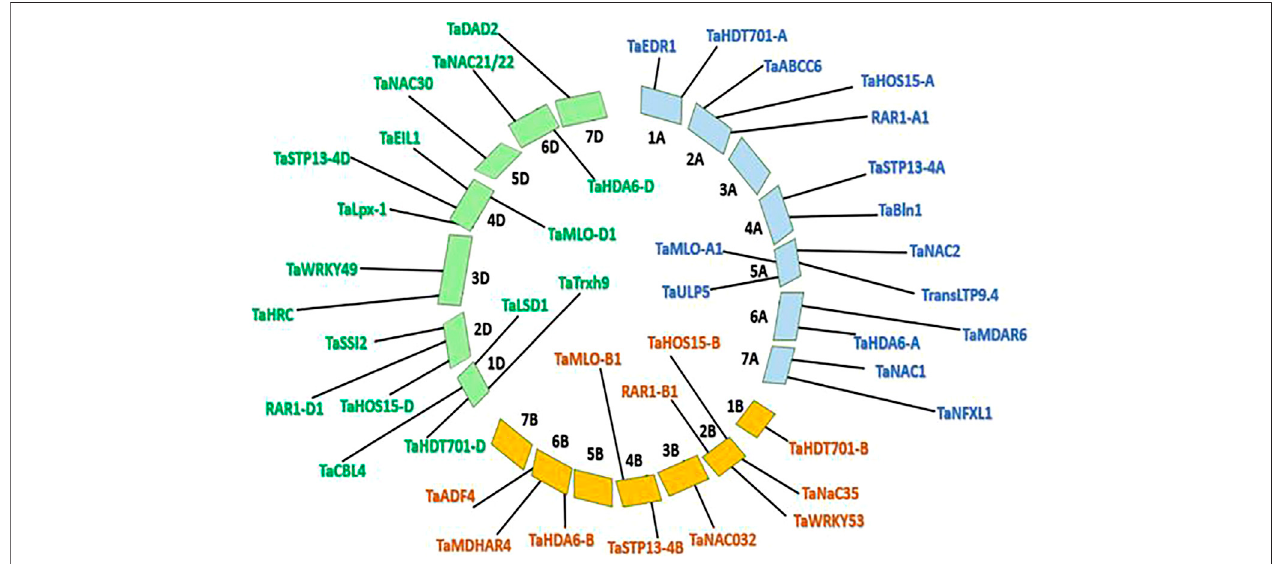
FIGURE 1 | Mapping of selected S genes on wheat genome using URGI